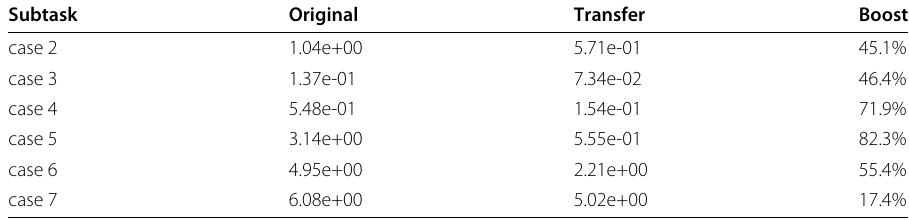
Table 1 Performance boost of PINN on the Helmholtz benchmarks using transfer learning Subtask Original